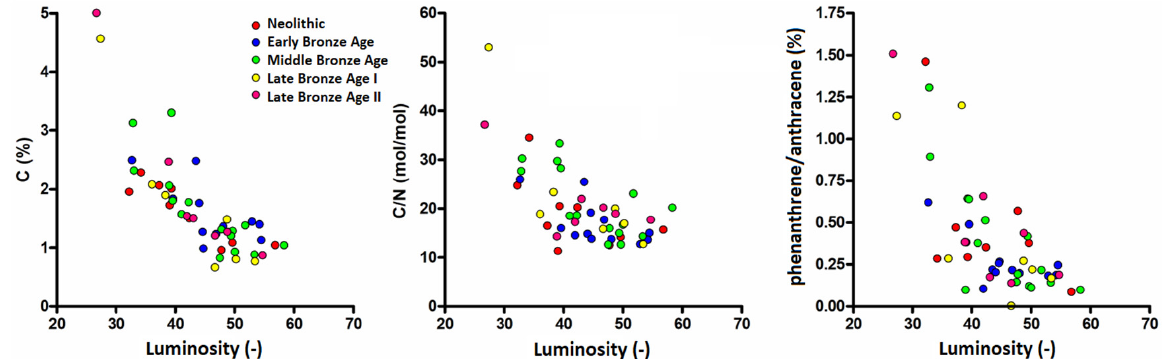
Figure 2. Relationship between luminosity (L*) and carbon ( left ), C/N molar ratio ( center ) and the relative proportion of co-eluting THM products phenanthrene and anthracene ( right ).